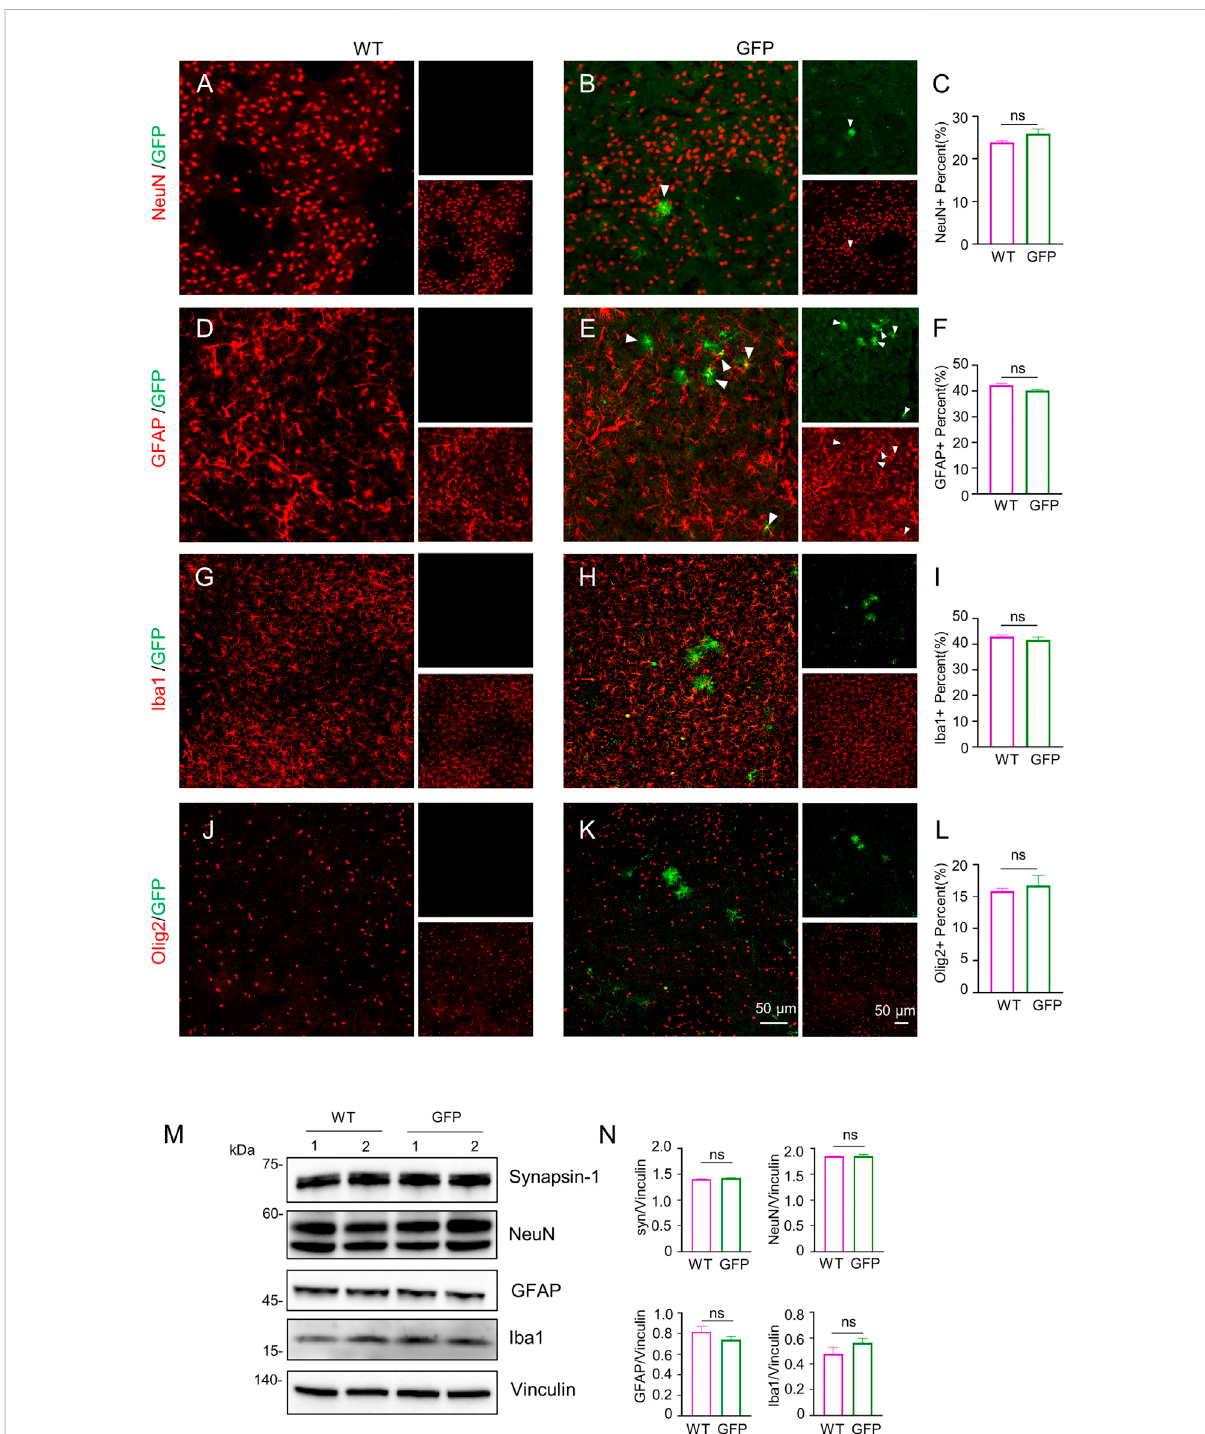
FIGURE 3 Immuno fl uorescentstainingofthepig ’ sstriatuminjectedwithAAV-GFPorsaline. (A – L) Doubleimmuno fl uorescentlabelingandquanti fi cation of neurons (NeuN) (A – C) , astrocytes (GFAP) (D – F) , microglial (Iba1) (G – I) and oligodendrocytes (Olig2) (J – L) of saline- or AAV-GFP-injected-wild typepigs.GFPpositivecellsareshowningreen,NeuN,GFAP,Iba1andOlig2positivecellsareshowninred.DataareanalyzedbyStudent ’ sT-testand presented as mean ± SEM. n = 3 animals per group. (M) Western blotting of the striatum of saline- or AAV-GFP-injected pigs with antibodies against synapsin-1, NeuN, GFAP and Iba1. Vinculin served as a loading control. (N) Quantitation of the ratios of synapsin-1, NeuN, GFAP or Iba1 to vinculin on the western blots. Data are analyzed by student ’ s T-test and presented as mean ± SEM. n = 3 animals per